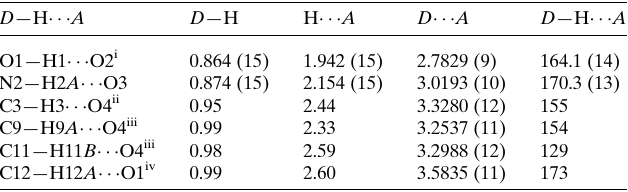
Table 1 Hydrogen-bond geometry (A˚ , (cid:3) ).